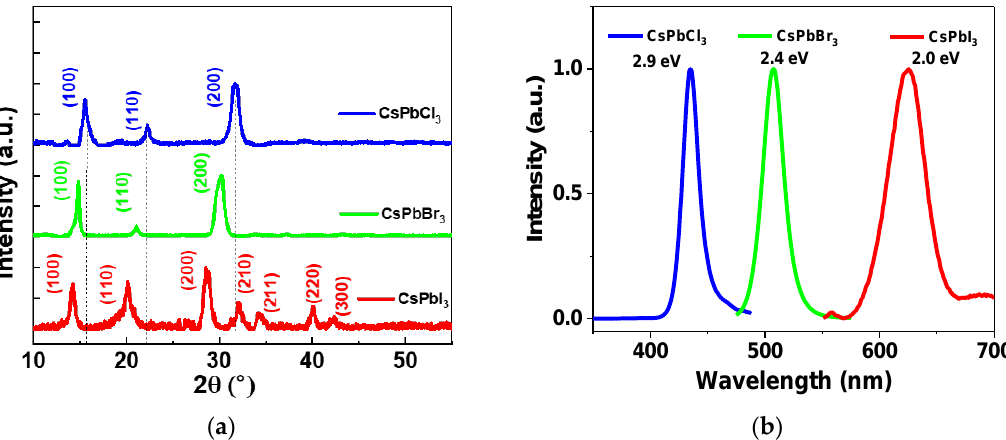
Figure 1. ( a ) X-ray diffraction patterns from CsPbX 3 perovskite synthesized by hot-injection methods. ( b ) Photoluminescence emission spectra of CsPbX 3 perovskite. Note that their main diffraction peaks and optical bandgaps are shown in inset of ( a ) and ( b ), respectively.